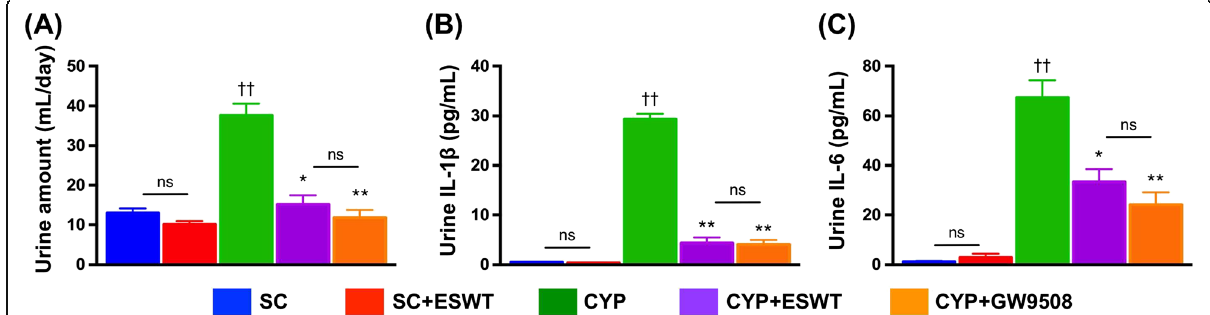
Fig. 5 The 24-h urine amount, and urine levels of interleukin (IL)-1 β and IL-6 by 72 h in rats following cyclophosphamide (CYP)-induced acute Interstitial cystitis. a 24-h urine volume, ( b-c ) Urine levels of IL-1 β and IL-6 by the end of 72 h in the five groups of animals ( n = 6 per group). Values expressed as the mean ± SEM. * p < 0.05, ** p < 0.01 vs. CYP; † p < 0.05, †† p < 0.01 vs. controls; ns, non-significance. Significance of differences determined by one-way ANOVA followed by Bonferroni ’ s post-hoc comparisons tests. SC = sham control; CYP = cyclophosphamide; ESWT =